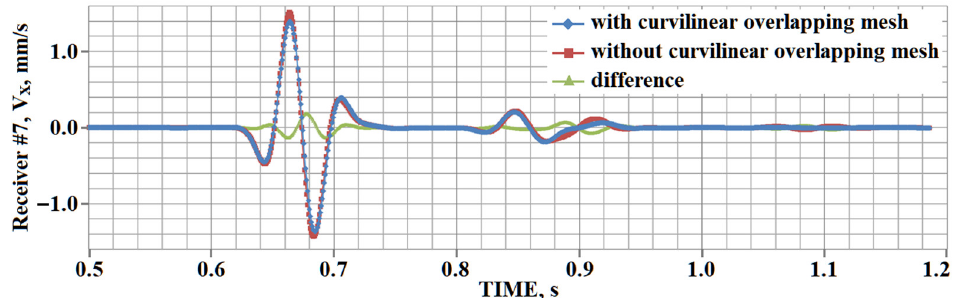
Figure 16. Receiver #7, dependencies of X-component of velocity on time.